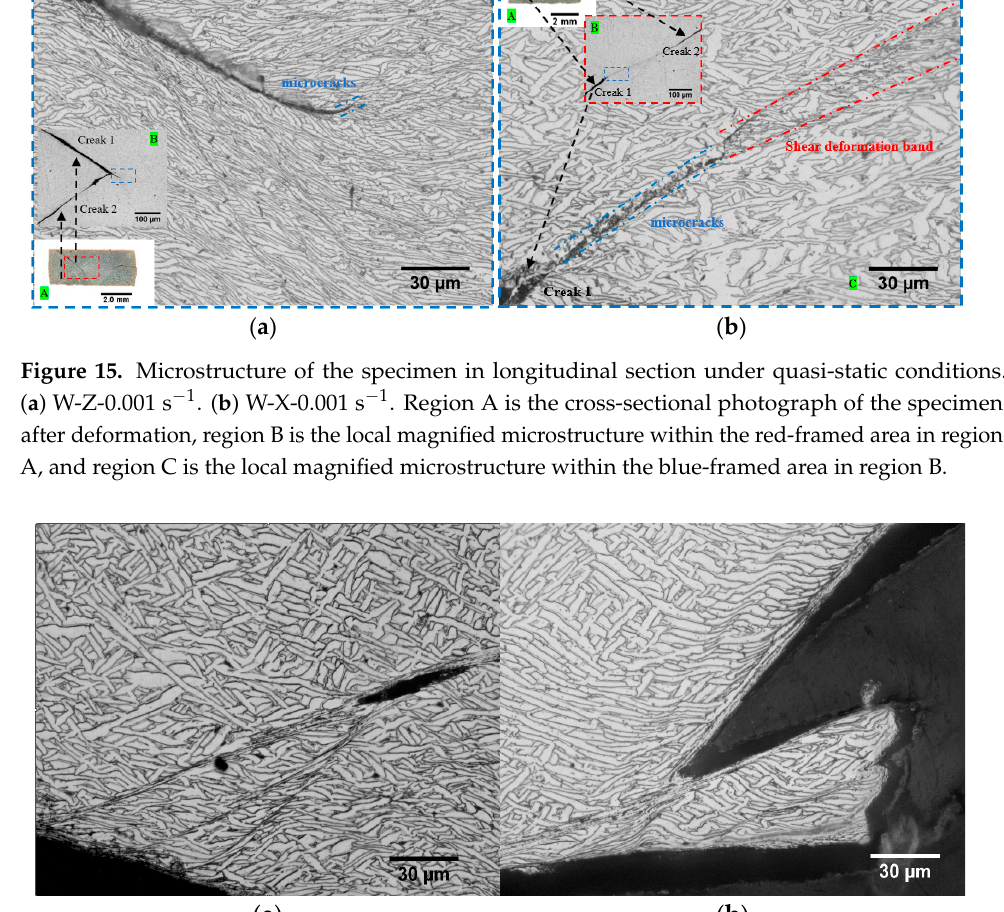
Figure 16. Microstructure of the specimen in longitudinal section under dynamic. ( a ) W-Z-3500 s − 1 . ( b ) W-X-4000 s − 1 .